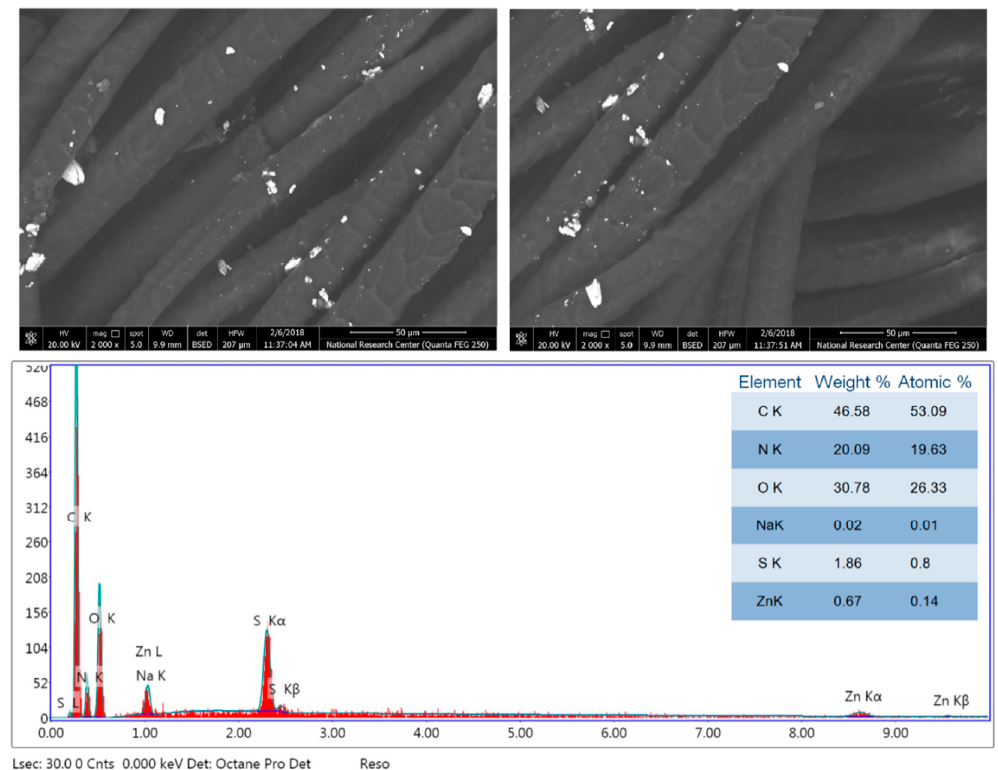
Figure 6. SEM images and EDX diagram of ZnO nanoparticles post-treated wool fabric screen-printed with C.I. Acid Red 88.